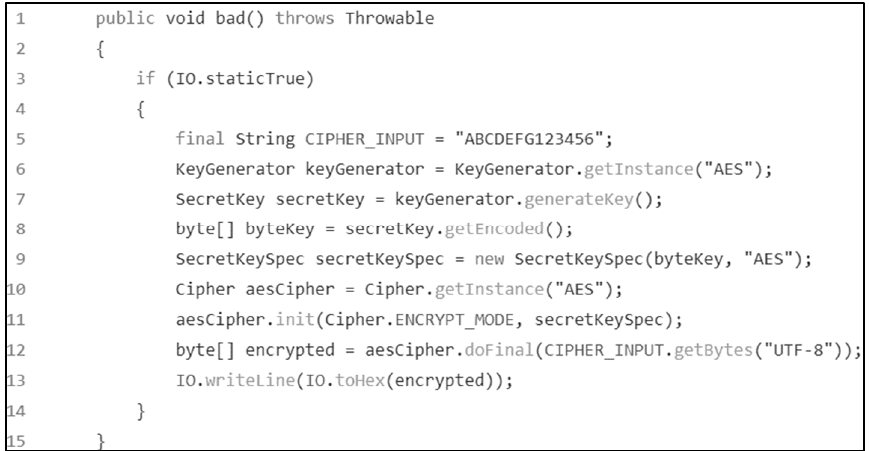
Figure 3. Vulnerable code snippets to CWE325 (Missing Required Cryptographic Step—Key Gen- erator, isolated from the Java dataset published by NIST.